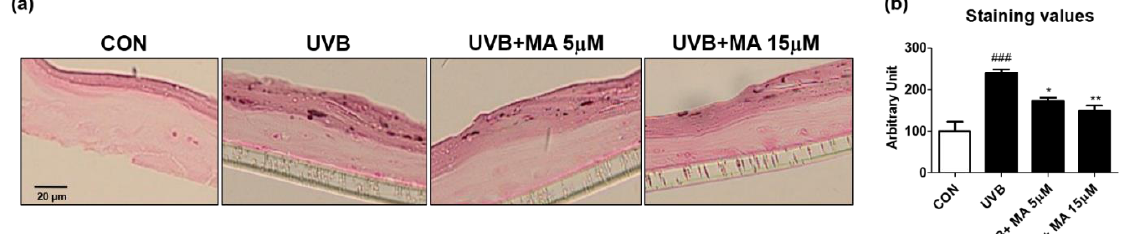
Figure 5 . Fontana-Masson staining results in 3D artificial human skin pretreated with maclurin. The pigmented human skin model (Neoderm-ME) was pretreated with maclurin and exposed to UVB radiation, followed by incubating in the maintenance media offered by the company for 5 days. ( a ) Fontana-Masson staining images showed differences in melanosome in the epidermis of the pigmented human skin model. ( b ) Fontana-Masson staining images were analyzed by the Image J analysis software. The results were represented the mean value ± SEM at least three times. All data were compared by ANOVA, followed by Dunnett ’ s multiple comparison test. ### p < 0.001 compared with the control group and * p < 0.05, ** p < 0.01 compared to the UVB-exposed group.